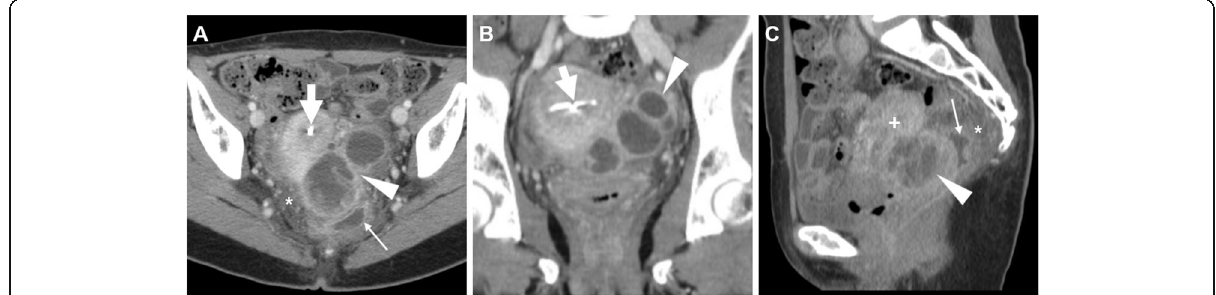
Fig. 19 a – c Multiplanar CT images of a complex, septated left-sided TOA (arrowheads) in a 42-year-old woman, with characteristic irregular peripheral enhancement, that displaces the retroverted uterus (plus sign). Note metallic intrauterine contraceptive device (IUCD, thick arrows), minimal peritonitis of the cul-de-sac (thin arrows) and inflammatory stranding of the presacral fat (asterisk). The IUCD had to be